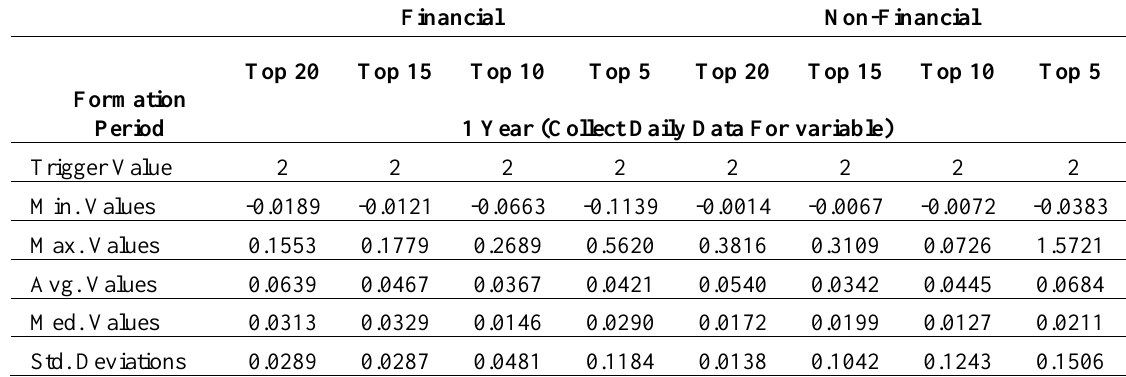
Table.2. Descriptive Analysis of Financial and Non-Financial Sector